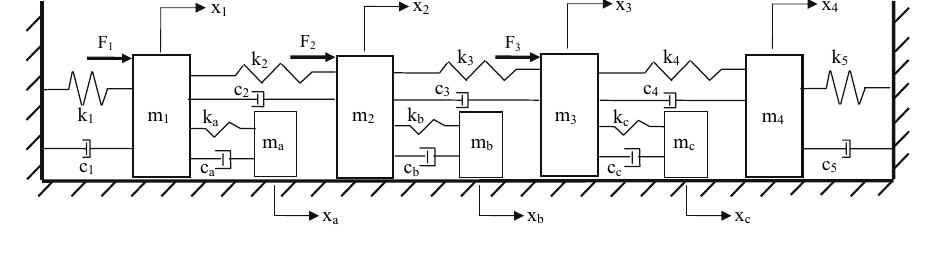
Fig. 13. System of four main masses with three